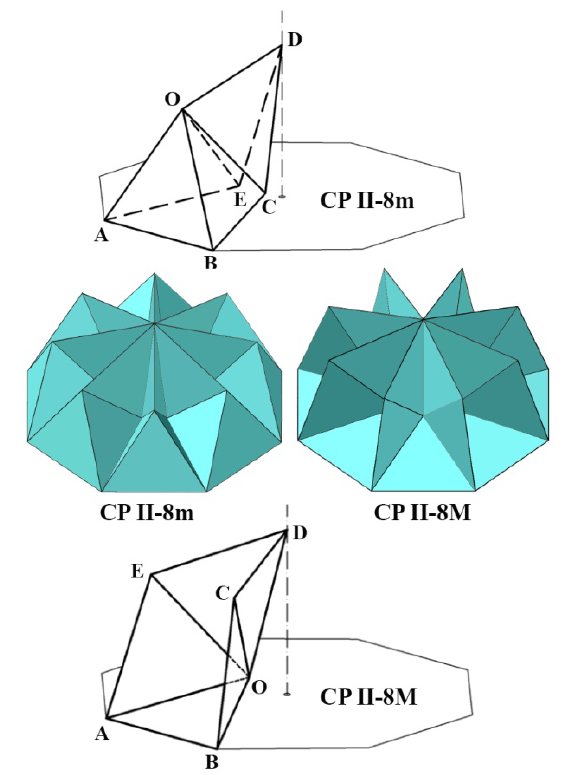
Figure 2. Method of generating the Concave pyramids of second sort by folding and creasing the plane net, obtaining two different types: CP II-8m, and CP II-8M